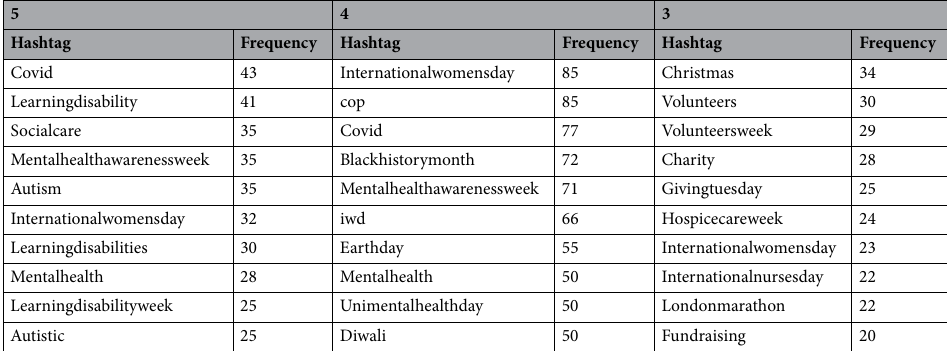
Table 6. Frequency of top 10 hashtags in the subcommunities with more than 50 nodes in Orange-red community, 2/2.